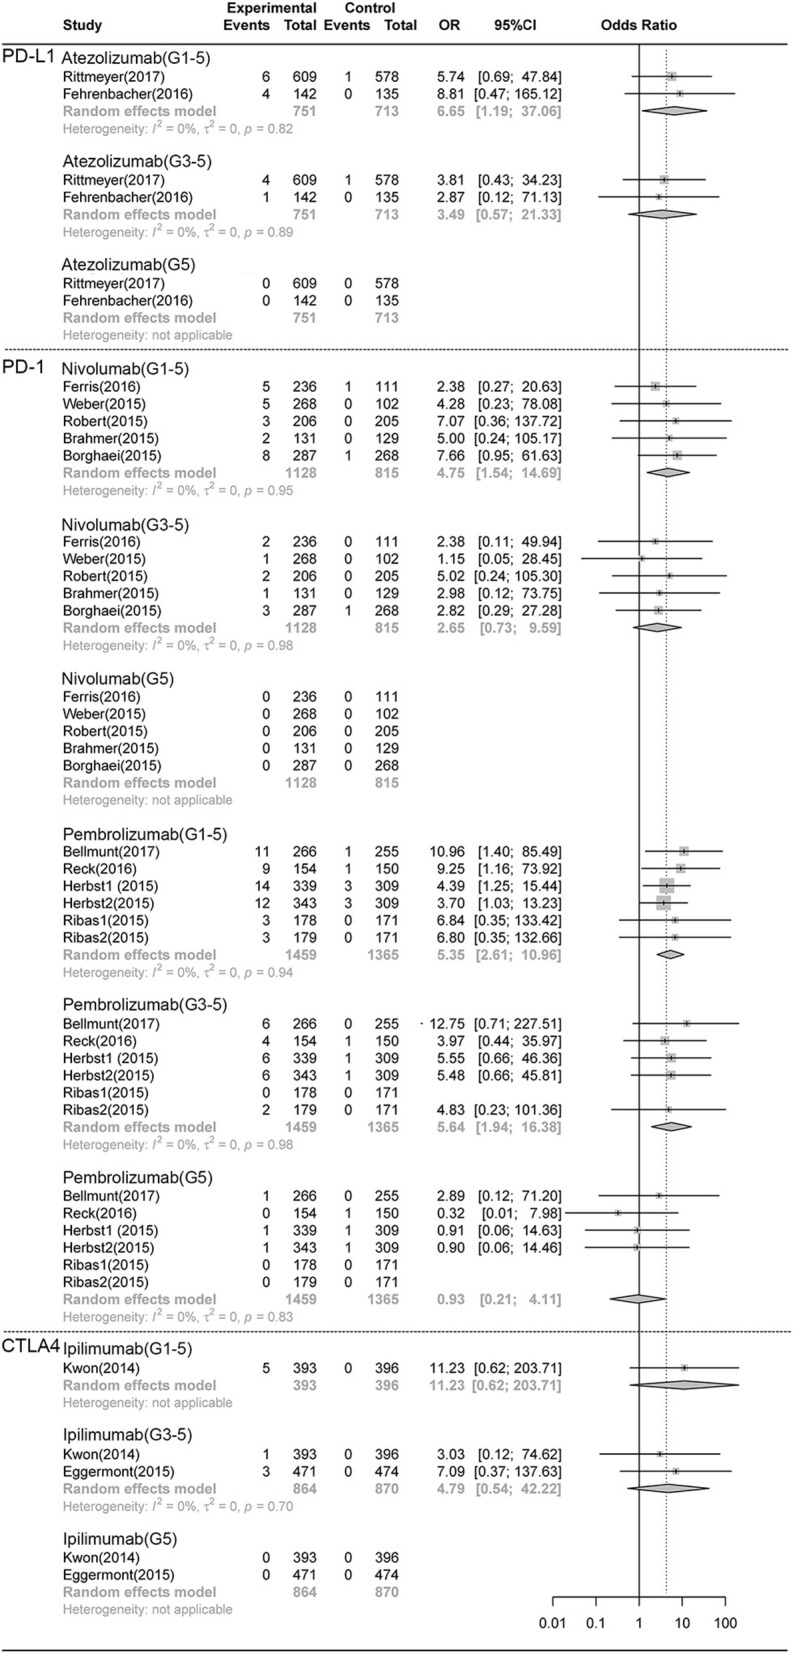
Forest plot analysis of pneumonitis comparing different ICIs with control therapies. Atezolizumab, atezolizumab V.S. chemotherapy; Nivolumab, nivolumab V.S. chemotherapy; Pembrolizumab, pembrolizumab V.S. chemotherapy; G1-5, grade 1-5; G3-5, grade 3-5, G5, death.